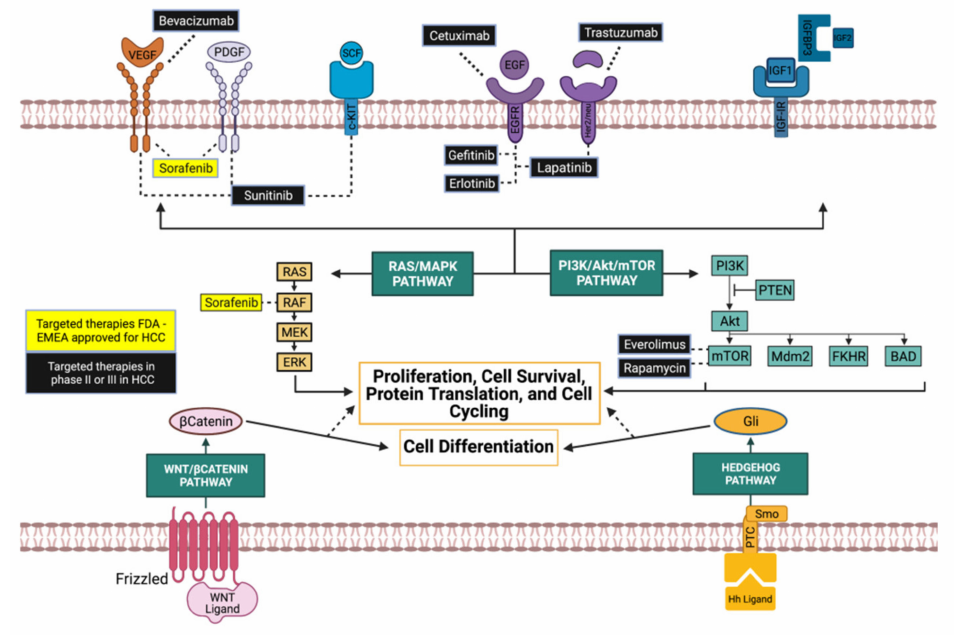
Figure 4. Molecular targeted therapies in HCC. Tyrosine kinase and mTOR inhibitors in preclinical studies or clinical trials for HCC. Some monoclonal antibodies directed against tyrosine kinase receptors are also indicated (Modified from [47]).